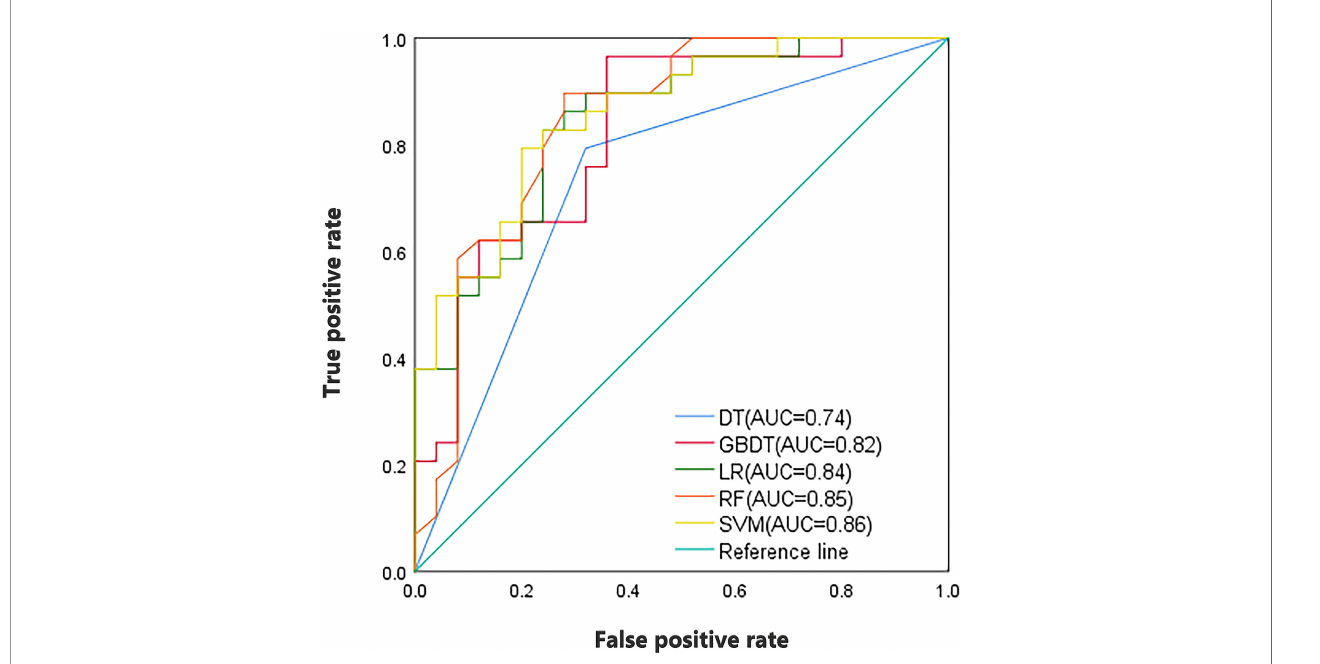
FIGURE 3 | ROC curves of the SVM, RF, LR, GBDT, and DT classi fi ers in validation set.